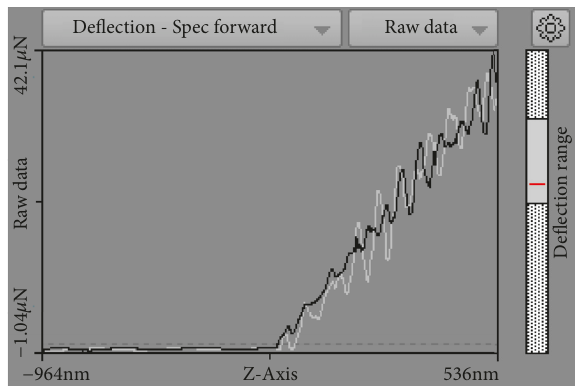
Figure 1: Force-distance curve for graphene oxide. The white line depicts the loading stage, while the black line represents the unloading